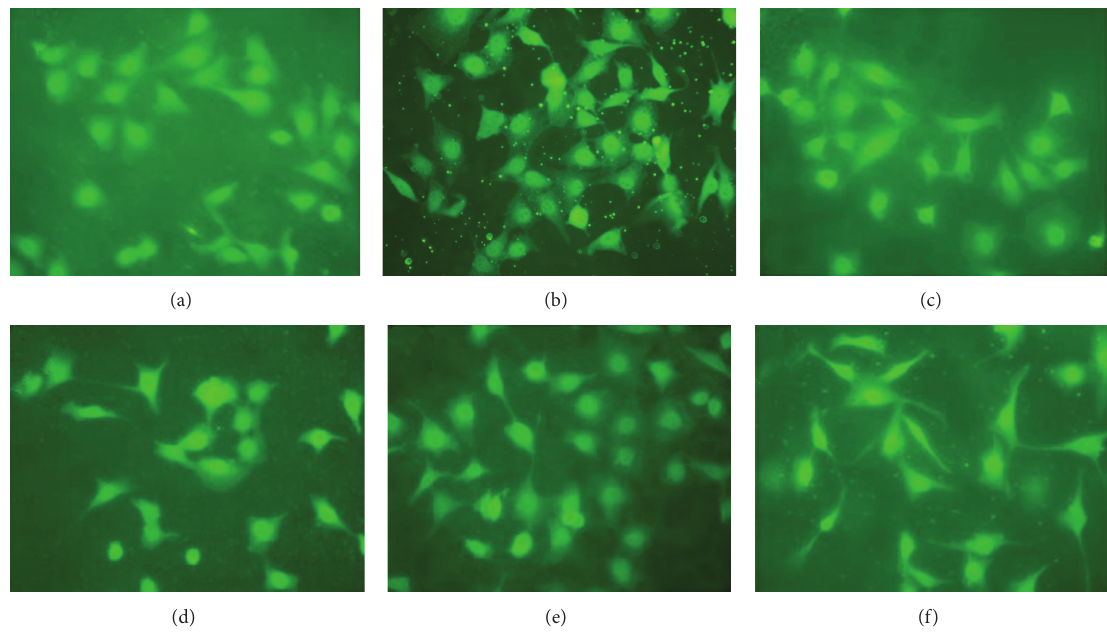
Figure 7: Immunofluorescence studies of EM1 on p38 MAPK in HUVECs. Cells were fixed, and incubated with p38 MAPK antibody and a FITC-conjugated second antibody. Pictures were taken at 400x magnification. ((a) BSA, (b) AGEs-BSA, (c) 10 𝜇 M, (d) 1 𝜇 M, (e) 0.1 𝜇 M, (f) 10nM).